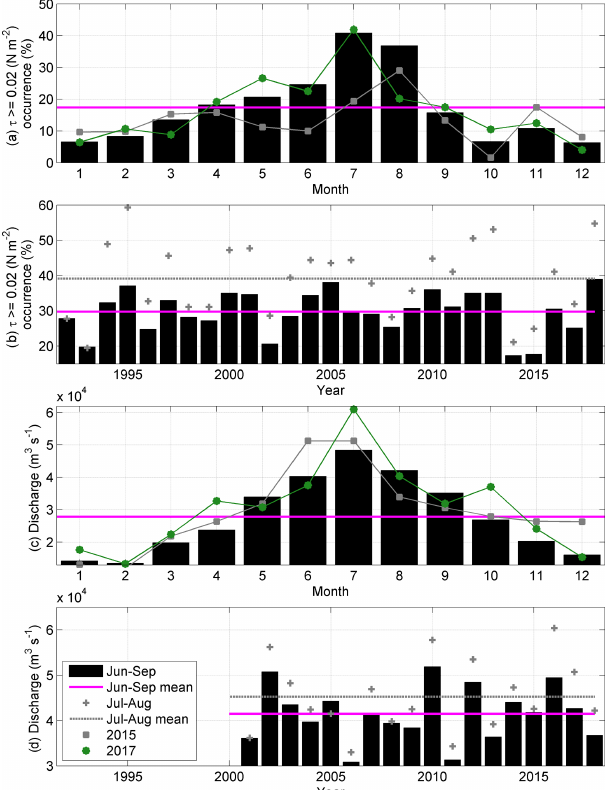
Figure 13. Annual cycle (a, c) and interannual variability (b, d) of wind stress component (1992–2018) τ c ≥ 0 . 02Nm − 2 (a, b) and river discharge (c, d)